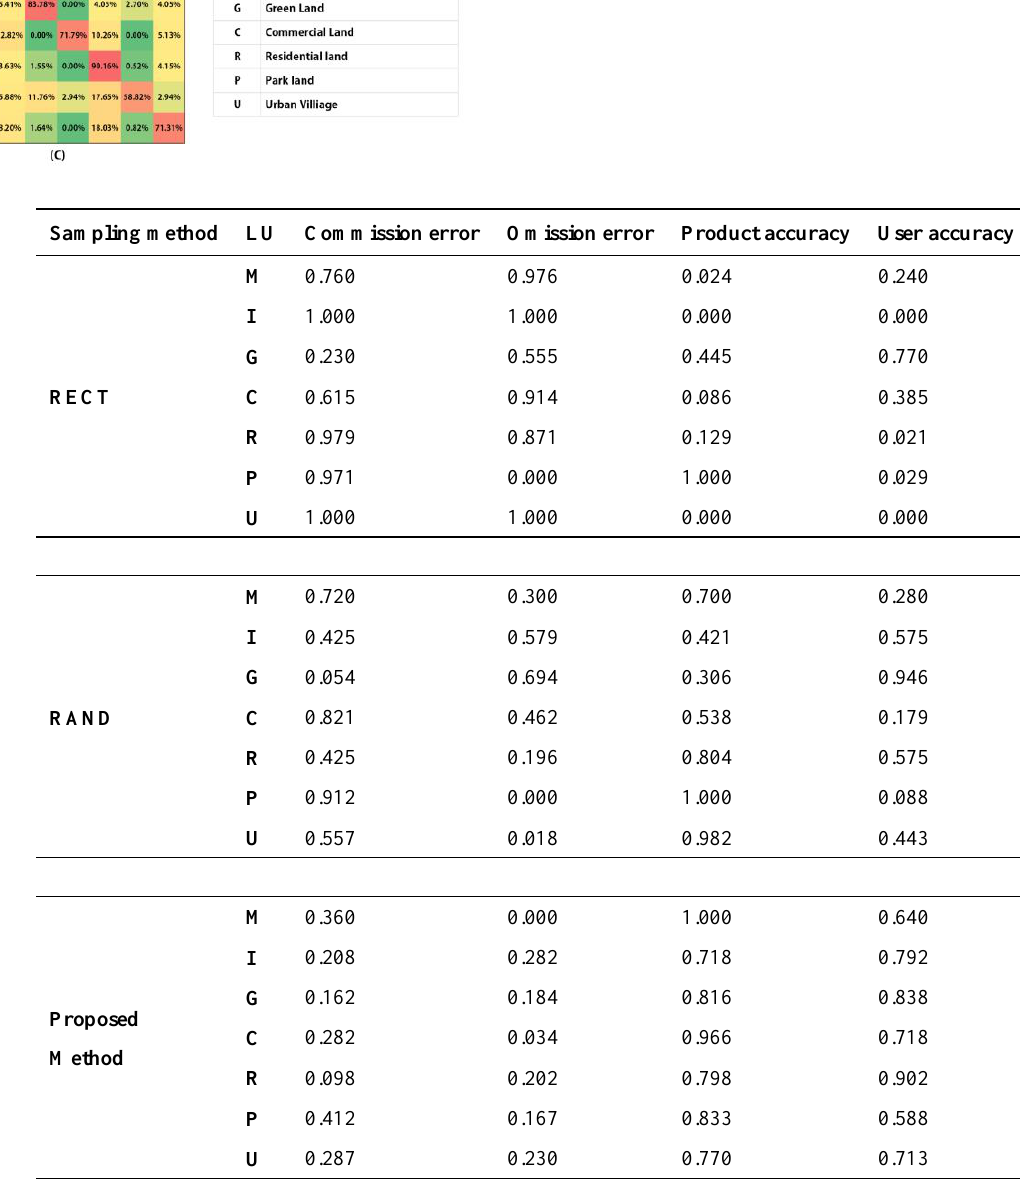
Table 2. Urban classification accuracy of each land-use type for the different